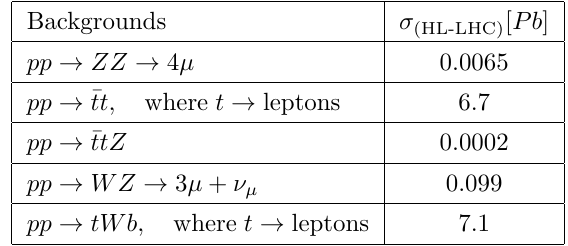
Figure 9 . Total cross sections for the process pp → H i → ZZ → 4 µ at the LHC with The scatter plot uses the results from the parameter space scan in section 3.5.